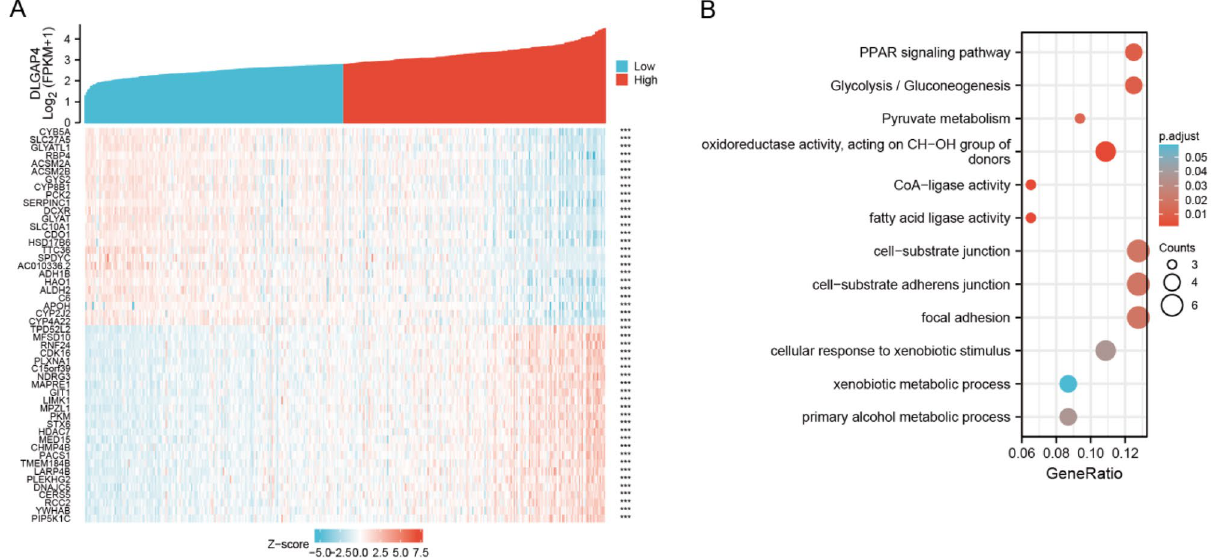
Figure 5. DLGAP4 functional clustering and interaction network analysis of DLGAP4-related genes. ( A ) Heatmap showing the top 50 genes in HCC that were positively and negatively related to DLGAP4. Red represents positively related genes, and blue represents negatively related genes. ( B ) Gene Ontology (GO) term and Kyoto Encyclopedia of Genes and Genomes (KEGG) pathway analyses of DLGAP4-related genes in